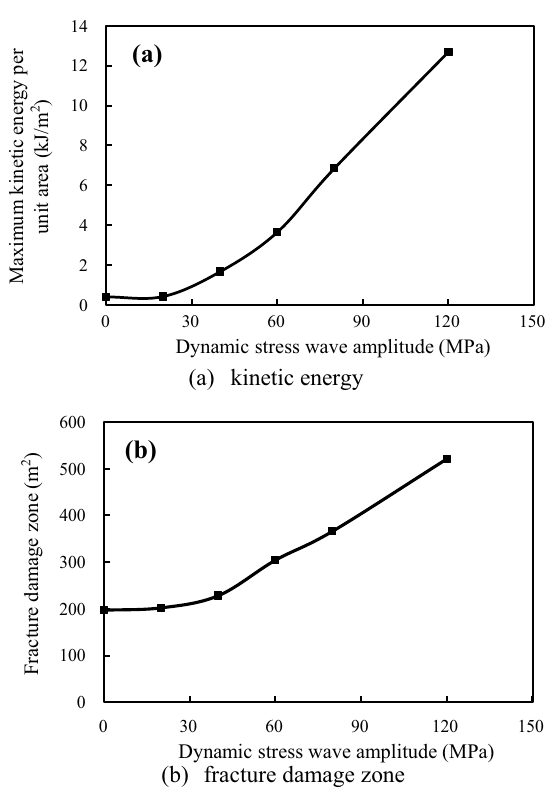
Fig. 10 Maximum kinetic energy per unit area and fracture dam- age zone distribution as functions of dynamic stress-wave amplitude (dynamic disturbances in vertical